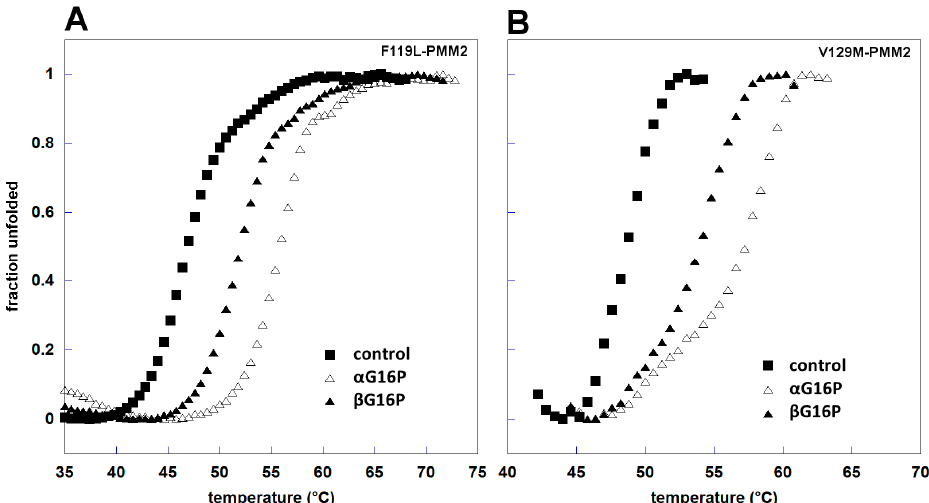
Figure 7. Thermal stability of pathological mutants in the presence of ligands. F119L-PMM2 ( A ) and V129M-PMM2 ( B ) 0.3 mg / mL were incubated with di ff erent ligands, α G16P (0.5 mM), and β G16P (0.5 mM). The melting curves were measured in the presence of DTT 1 mM and Sypro Orange 2.4x, from 20 to 90 ◦ C with increments of 1 ◦ C / min.